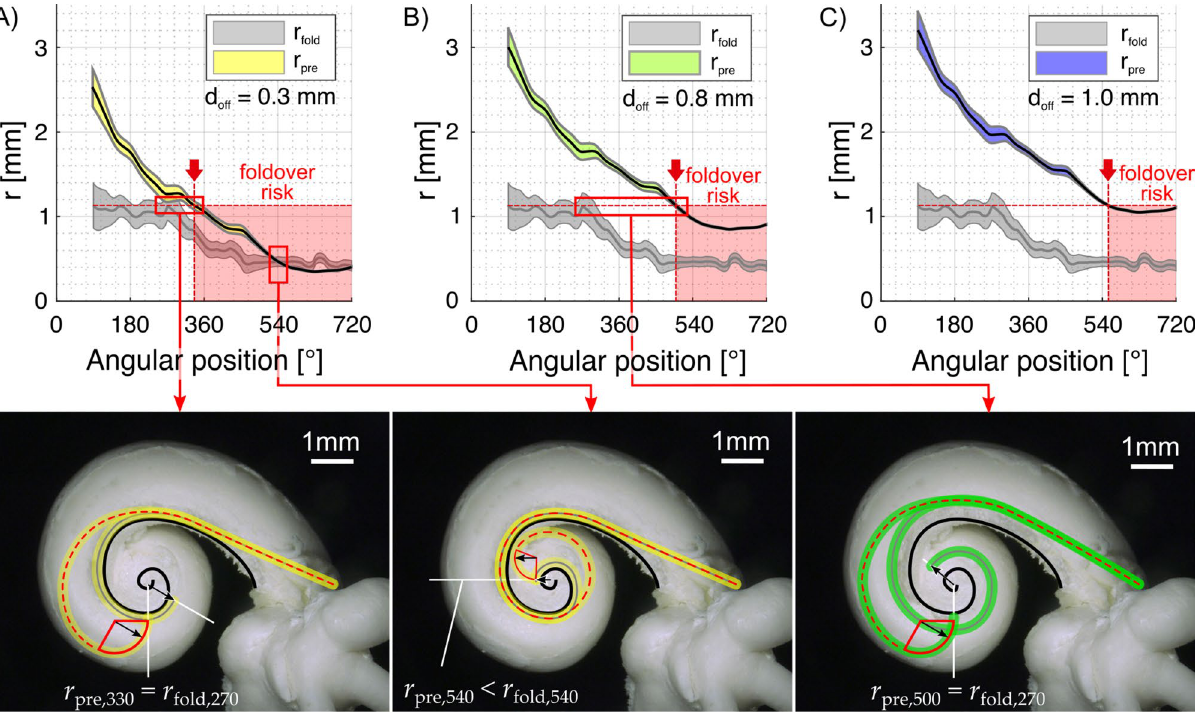
Figure 10. Mean (± standard deviation) of the radius ( r pre , i.e. the curvature of the preformed implant, and r fold , i.e. the critical radius for tip fold-over, see Fig. 2) as a function of angular position from the round window for the three different designs of the implants, with three different assumed distances from the modiolus (( A ) 0.3 mm; ( B ) 0.8 mm and ( C ) 1.0 mm). For comparison, mean values for the critical radius are shown in grey. Data obtained from corrosion casts. The red line depicts the maximal critical mean radius of 1.13 mm (occurring at about 270°). The red arrow points to the angular position at which this line intersects the individual optimal array curvatures. Beyond this point, this curvature would lead to an increased risk of fold-overs because it allows the array tip to buckle up on the modiolus (see Fig. 2A). The bottom images show examples of (from left to right) desired and critical curvature occurring at a similar angular location, the danger of the critical radius being even larger than the desired array radius and the desired curvature at an angle beyond 360° yielding an increased risk of tip fold-overs within the basal